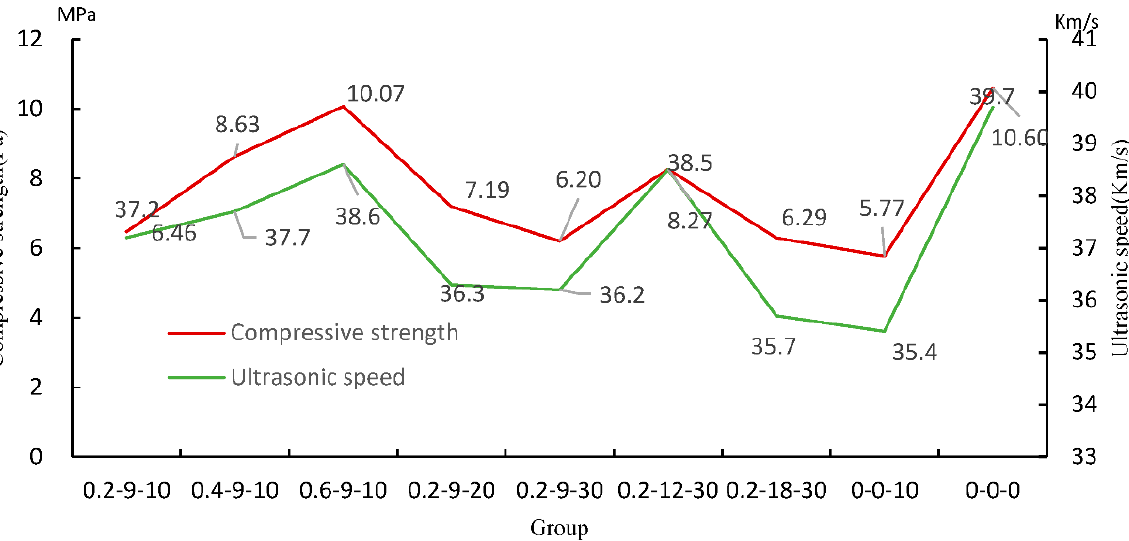
Figure 14. Contrast diagram of the ultrasonic wave velocity and compressive strength.